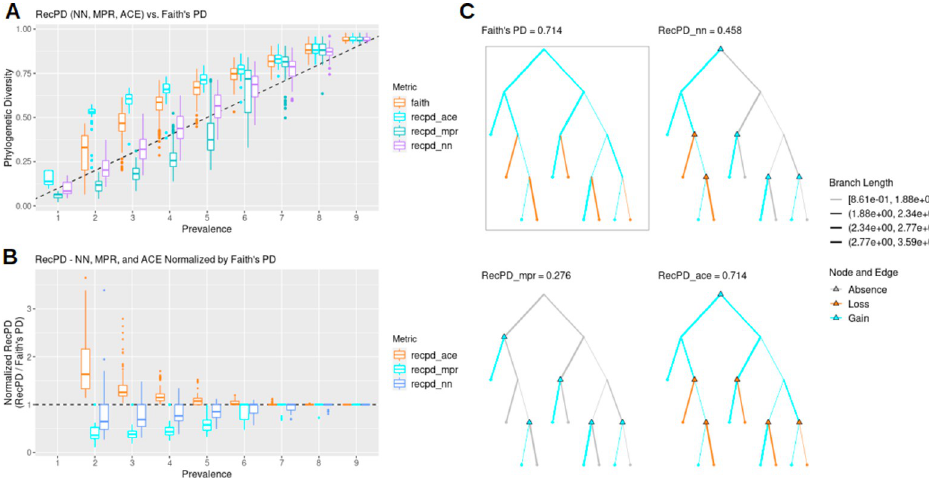
Fig 2. RecPD results in lower PD estimates compared to recombination-agnostic Faith’s PD and is affected by ancestral state reconstruction approach employed. (A) RecPD using three ancestral state reconstruction methods (NN, MPR, and ACE) and Faith’s PD distributions binned by gene family prevalence. Results shown correspond to all 1022 possible randomized gene-family distributions mapped onto a randomly generated example tree topology of ten tips. (B) RecPD normalized by Faith’s PD for three ancestral state reconstruction methods binned by gene-family prevalence. Results shown correspond to all 1022 possible randomized gene-family distributions mapped onto a tree of ten tips. (C) Example gene family distribution of prevalence = 5 illustrating differences in inferred evolutionary events using different methods: Faith’s PD = 5 losses, 0 gains (boxed), RecPD(NN) = 2 losses, 4 gains, RecPD(MPR) = 0 losses, 5 gains, and RecPD(ACE) = 5 losses, 0